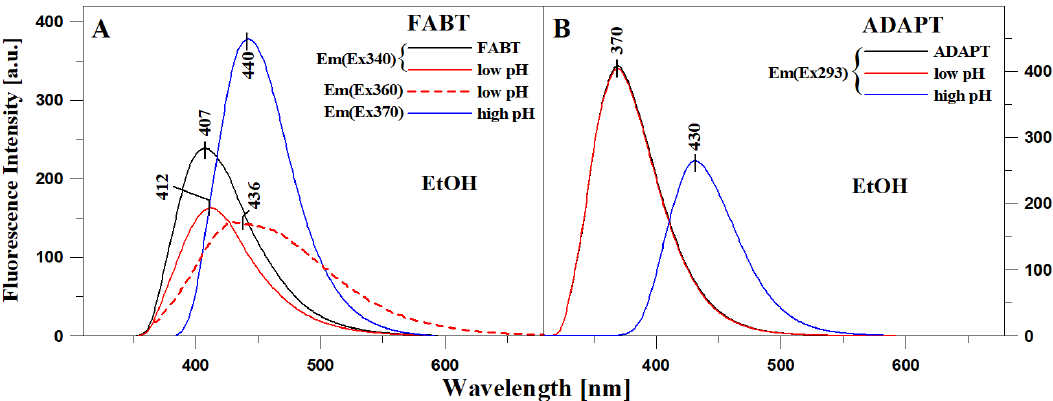
Figure 5. Emission fluorescence spectra corresponding to the absorption spectra in Figure S7 for FABT (Panel ( A )) and ADAPT (Panel ( B )).